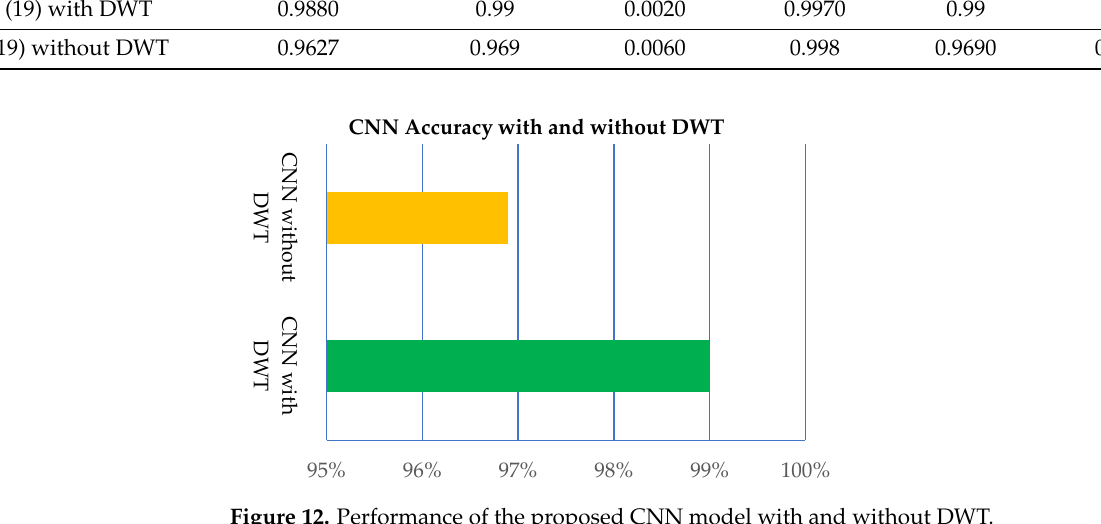
Figure 12. Performance of the proposed CNN model with and without DWT.